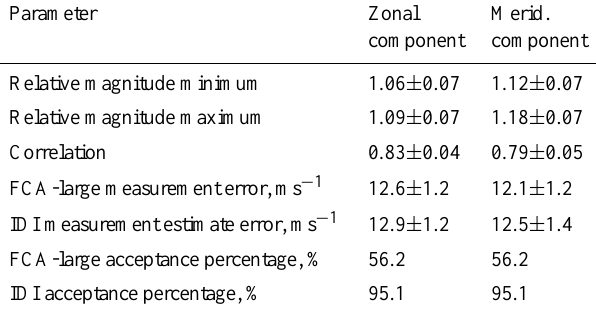
Table 3. Mean and standard deviation of daily relative magnitude minima and maxima, correlation, maximum measurement errors, and acceptance percentages for IDI with respect to FCA-large for 20 August 2000 to 19 September